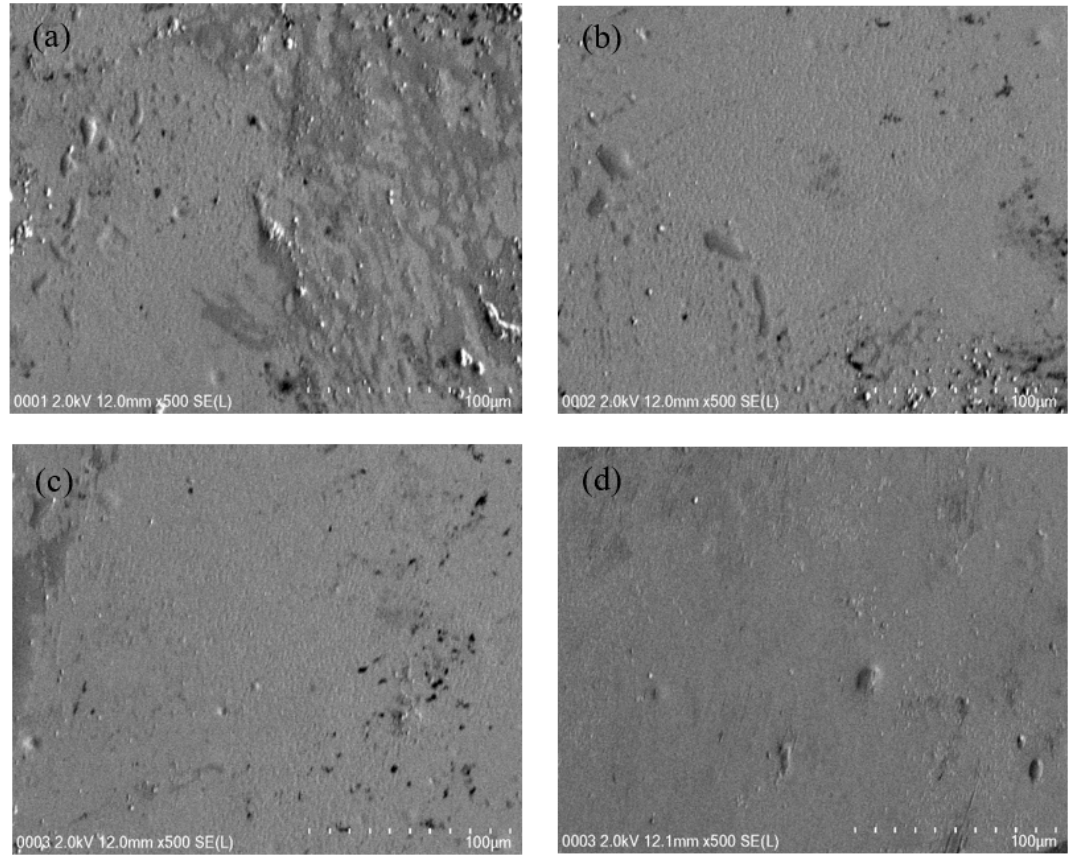
Figure 3. Field emission scanning electron microscopy (FESEM) images ( a ) CSNZG0, ( b ) CSNZG1, ( c ) CSNZG2, and ( d ) CSNZG3 electrolyte films.